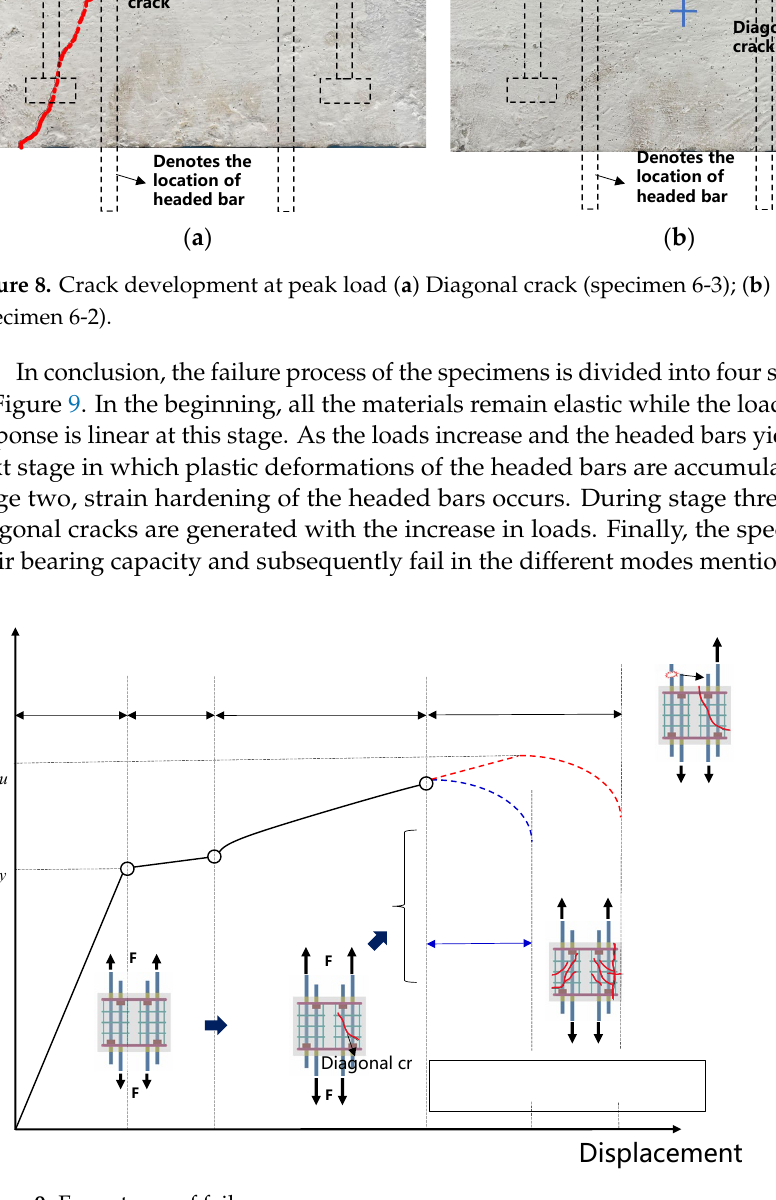
Figure 9. Four stages of failure process.